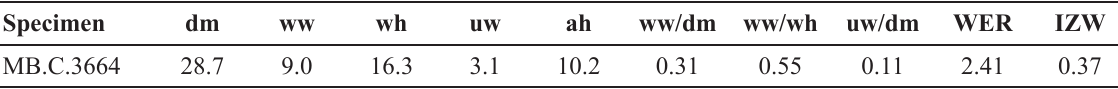
Table 6. Conch dimensions and ratios of Taouzites acutus (Matern, 1931). Specimen dm ww wh uw ah ww/dm ww/wh uw/dm WER IZW MB.C.3664 28.7 9.0 16.3 3.1